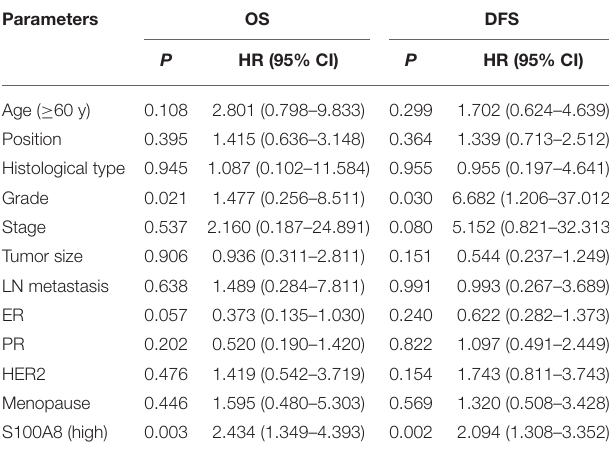
TABLE 3 | Multivariate survival analysis for OS and DFS in breast